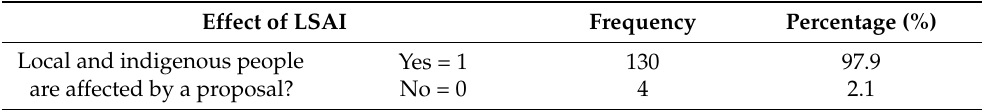
Table 3. Local people affected by the proposal n = 134